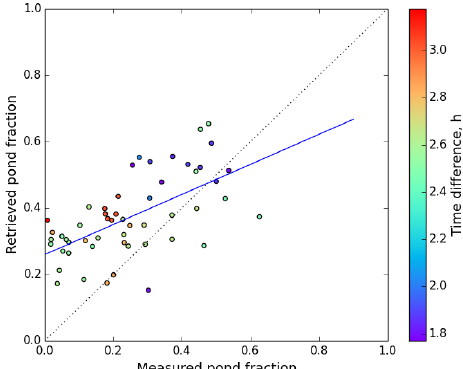
Figure 13. Correlation between retrieved melt pond fractions from satellite- and airborne-classified MPs over FYI, possible drift, 7 June 2008, MELTEX2008, Beaufort Sea. This case features larger ice floes than flights on 4 June or 26 May 2008. N = 53, R 2 = 0.37, RMS =